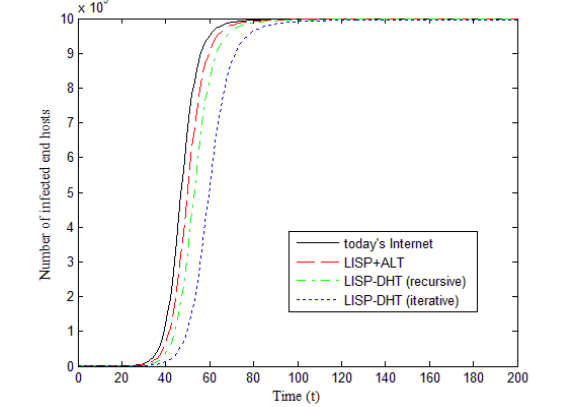
Fig. 4. Number of infected end hosts with different mapping delays.